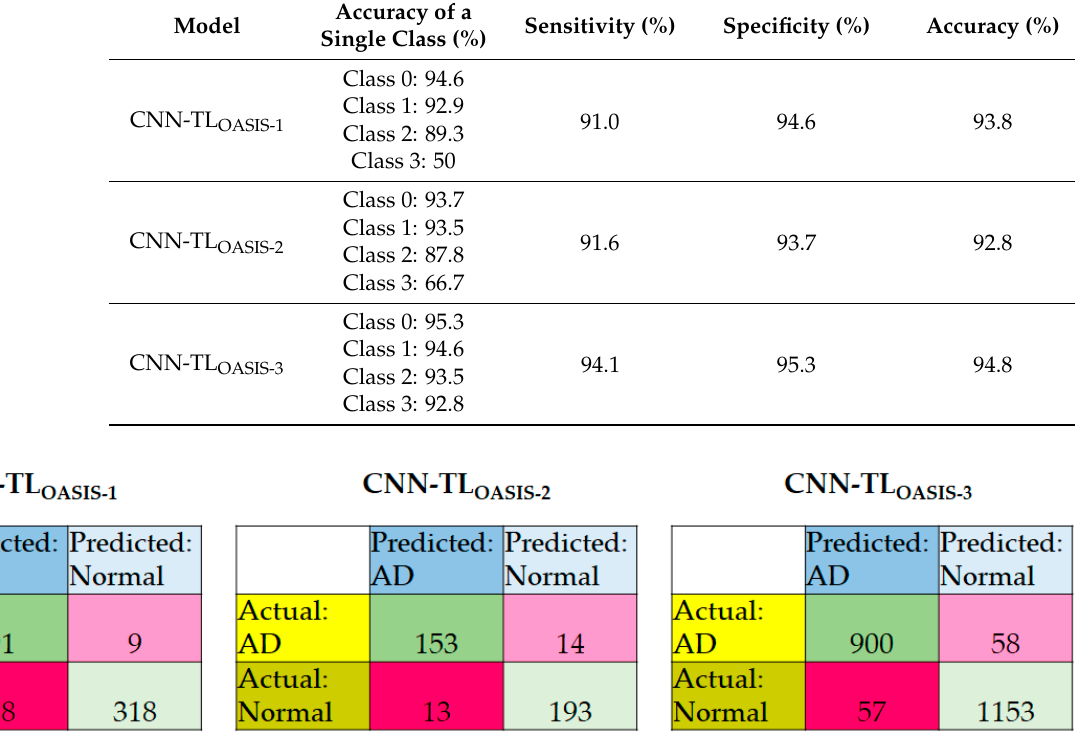
Table 4. Performance evaluation of the GAN-CNN for OASIS-1, OASIS-2, and OASIS-3. Accuracy of a Model